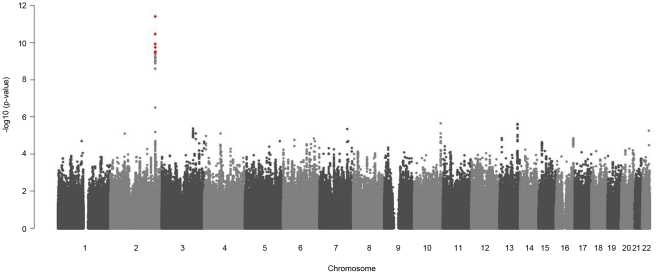
Manhattan plots for gender-specific genome-wide beta-differences for the metabolite glycine.Genome-wide significant beta-differences are plotted in red (significance level p<3.8×10−10).